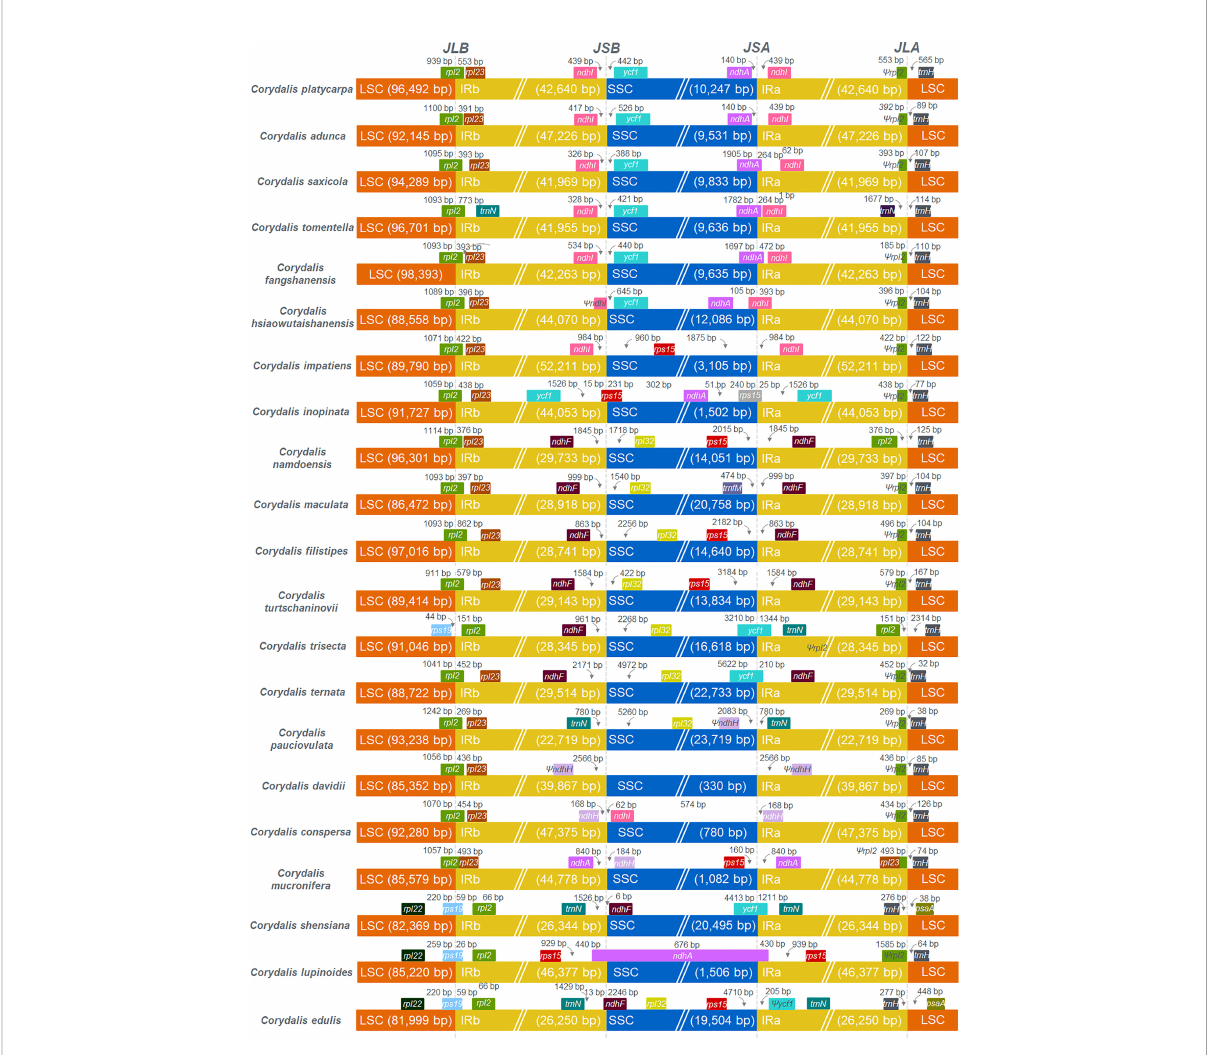
FIGURE 3 Comparison of the borders of LSC, SSC, and IR regions among 21 Corydalis chloroplast genomes. JLB indicates the junction line between LSC and IRb; JSB indicates the junction line between SSC and IRb; JSA indicates the junction line between SSC and IRa; JLA indicates the junction between LSC and